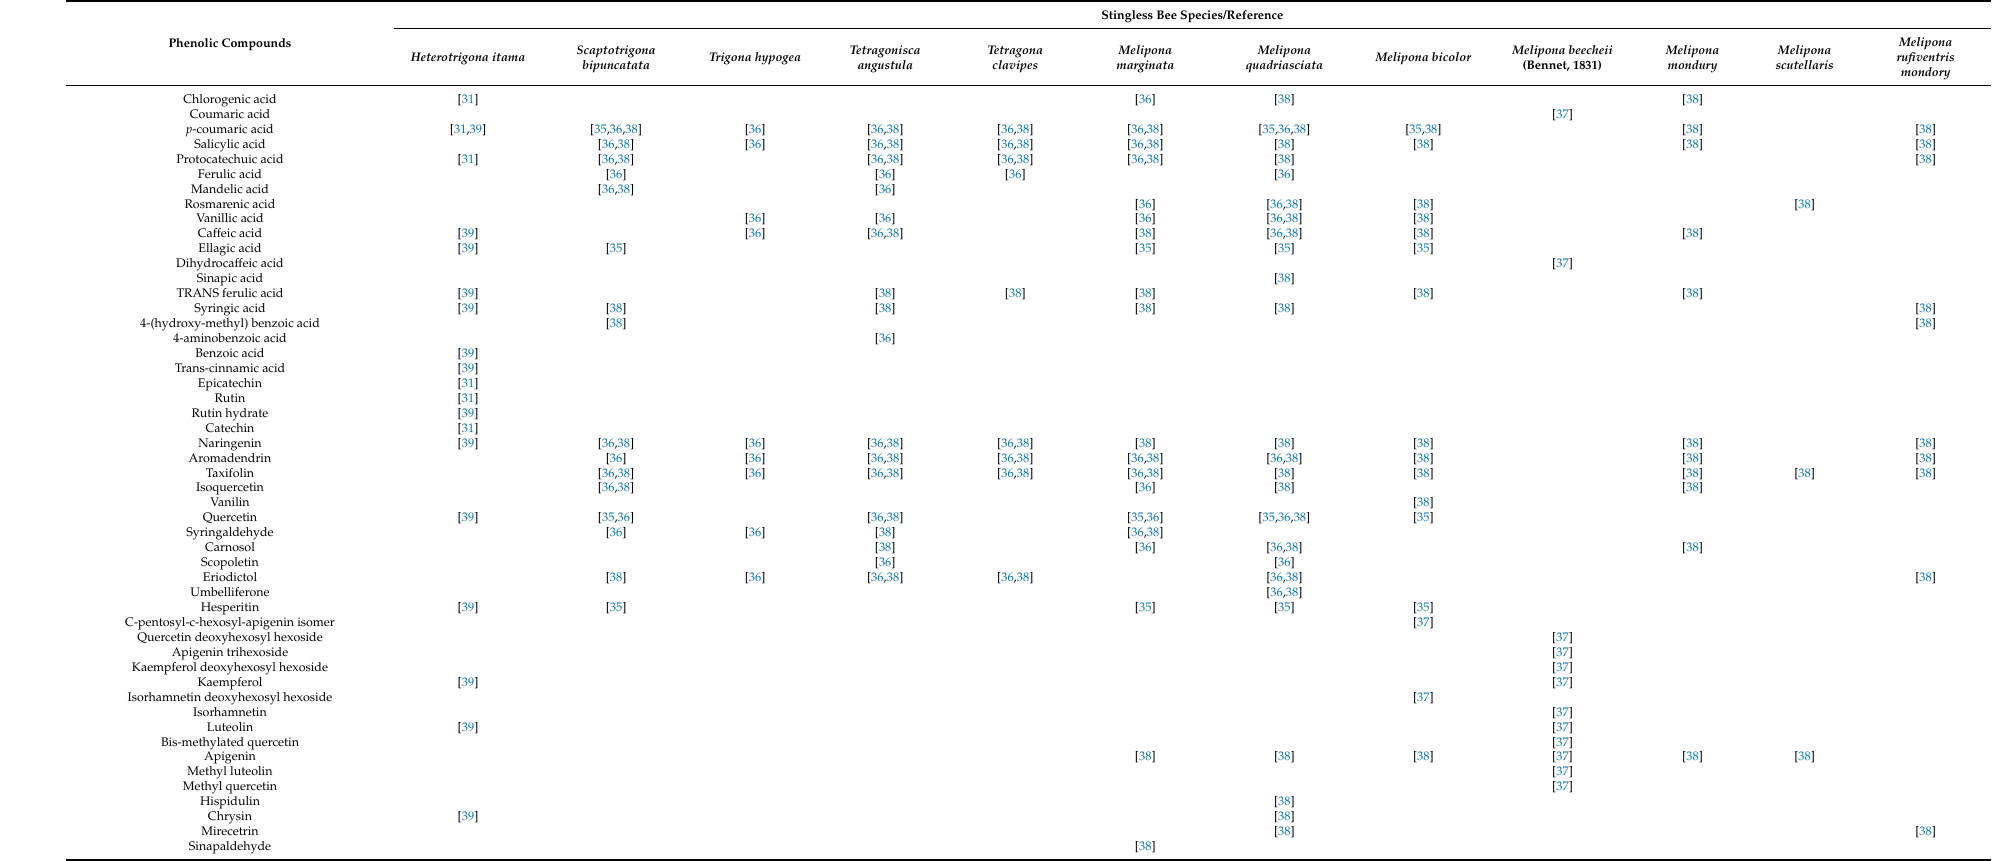
Table 2. Individual phenolic compounds in stingless bee